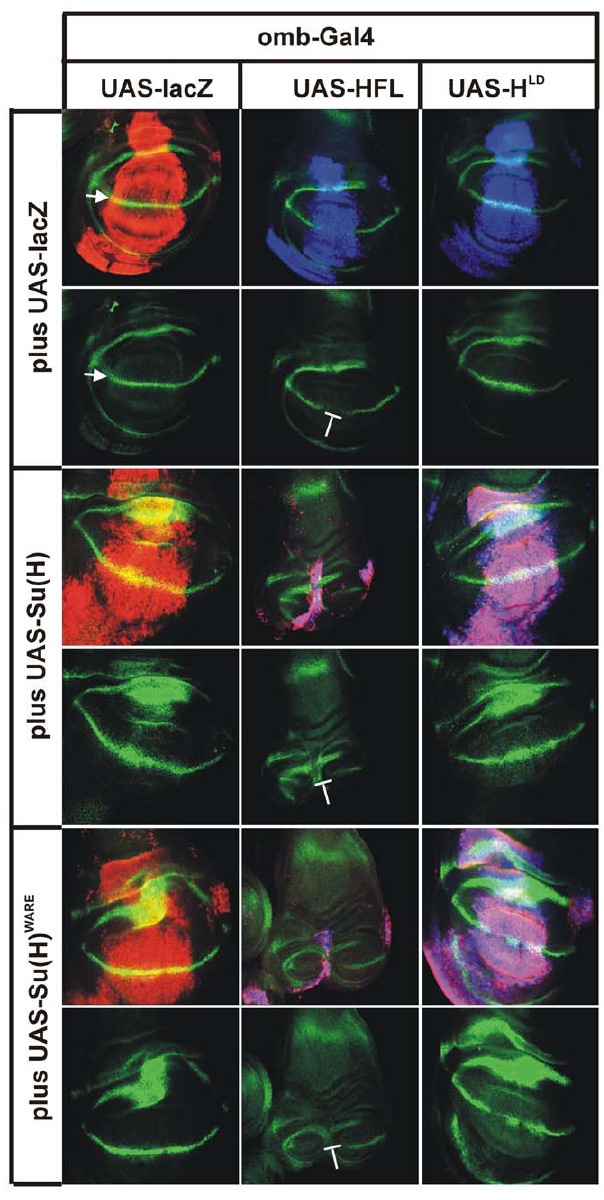
Figure 5. In vivo influence of the Su(H) and Hairless protein variants on the Notch target wingless . Wingless (wg) protein is expressed along the dorso-ventral boundary of the wing imaginal disc as a result of Notch signalling (see arrow in lac-Z control) [17,18]. Wingless protein is shown in green in all panels. Su(H) and Hairless variants were overexpressed using the Gal4/UAS system within the central part of the wing disc (red in lac-Z control). Apart from the beta- galactosidase control, red depicts Su(H) protein. Hairless protein is shown in blue; overlap with Su(H) appears magenta and in addition with wg, it appears white. The control disc shows the expression domain (red, beta-galactosidase) of the omb -Gal4 driver. Wingless (Wg) protein outlines the wing pouch and dissects it along the dorso-ventral boundary (arrow). The latter expression is induced by a Notch signal. Overexpression of wild type Hairless (blue) represses Wg expression (blunt bar). In contrast, the mutant H LD is unable to repress Wg. Overexpression of wild type Su(H) (red) causes proliferation of the wing blade and a subtle expansion of Wg expression. A combined overexpression of Su(H) and Hairless gives a super-additive effect: the expression domain becomes very small and Wg expression is inhibited. The mutant H LD has no such effect; the combination with Su(H) resemble the sole Su(H) overexpression reflecting lack of binding of